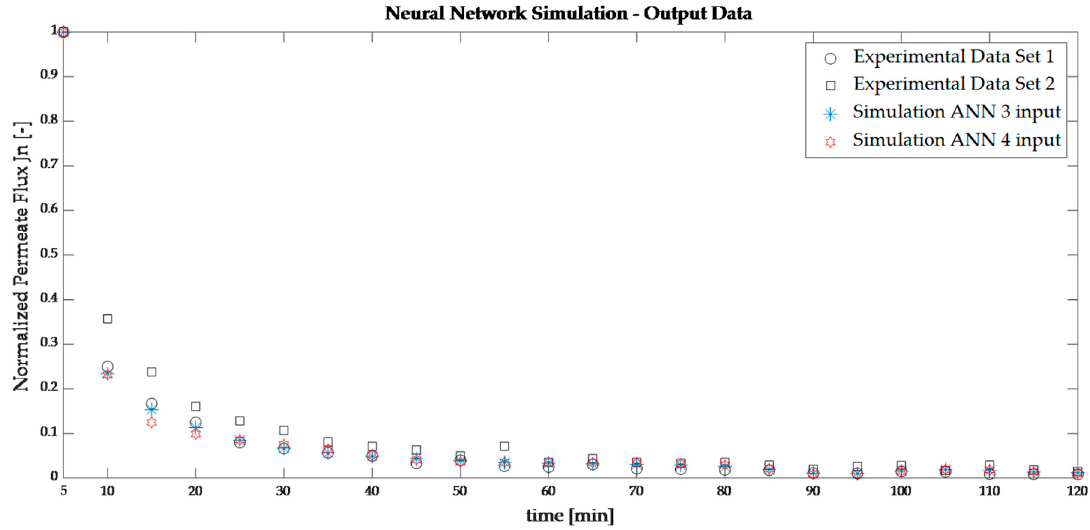
Figure 6. Post simulation analysis—comparison between both experimental data sets used in the simulation phase and ANNs developed with three and four inputs.